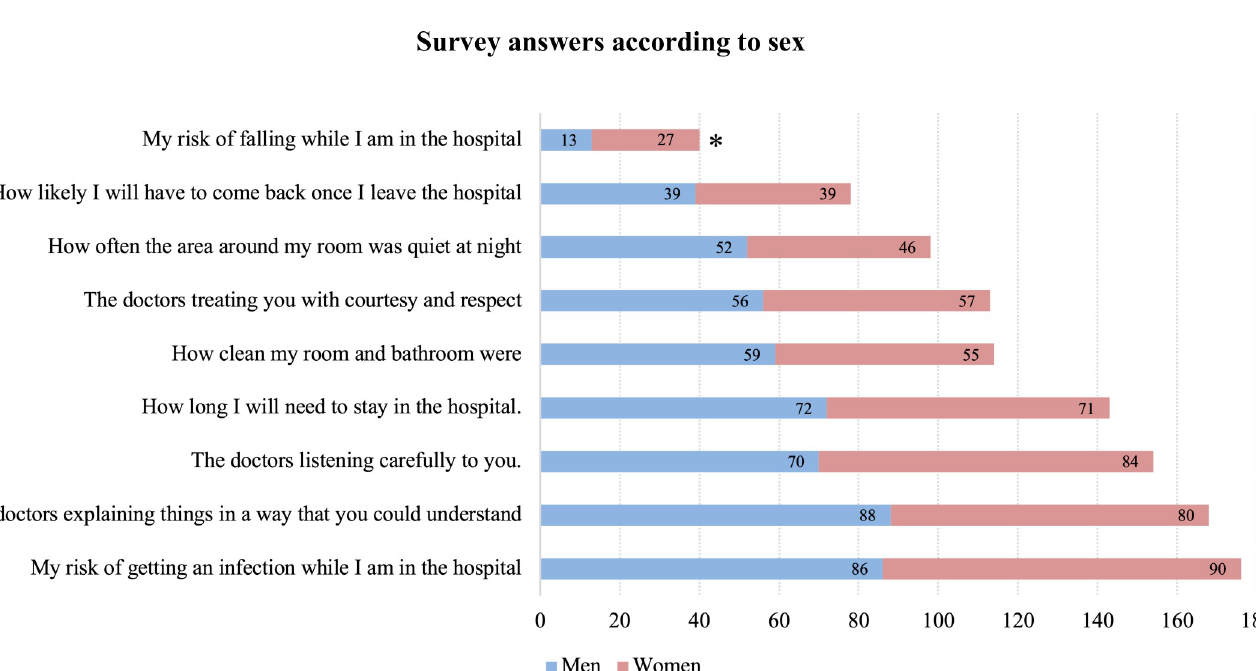
Fig 2. Survey answers according to sex. Frequency of participants that answered each question as “Very Important” in the hospital care, according to sex. � Statistically significant.